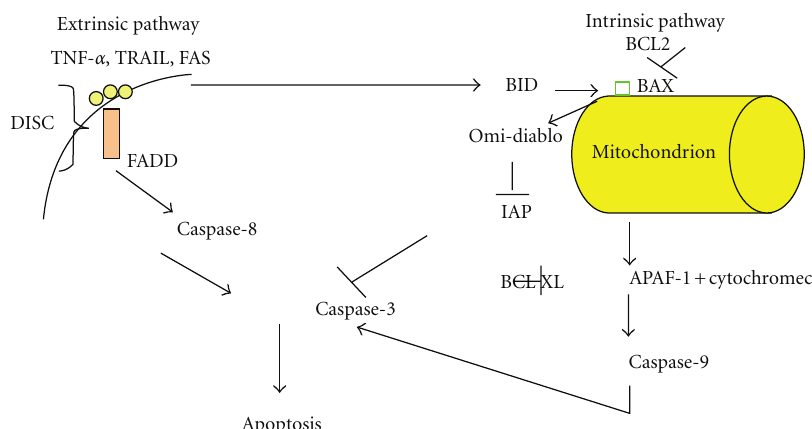
Figure 1: In this figure we show the two main pathways to apoptosis, and their interaction through the molecule BID, since death receptors activate the intrinsic pathway by activating BID. Either BAX or BAK are required for apoptosis, where they oligomerize in the mitochondrial outer membrane and induce the release of cytochrome c. DISC: death-inducing signaling complex, FADD: FAS-associated protein with death domain, TRAIL: TNF-related apoptosis-inducing ligand, APAF-1: apoptotic protease-activating factor, IAP: inhibitor of apoptosis